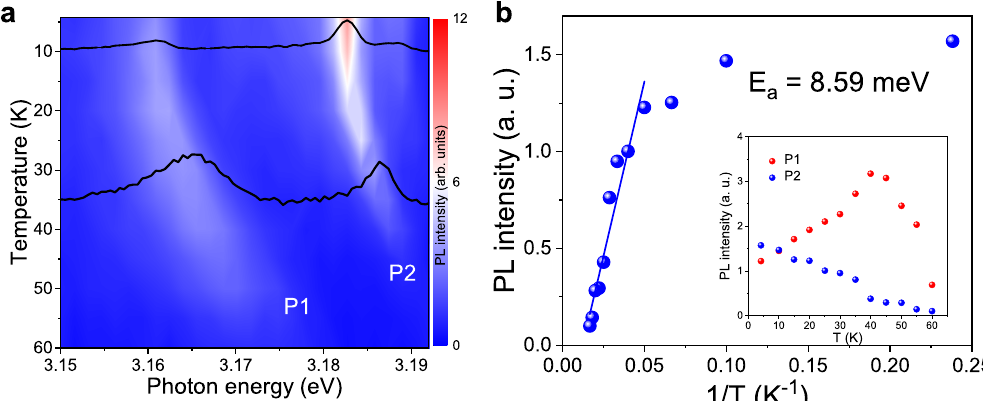
Fig. 1 Temperature-dependent micro-photoluminescence. a Temperature-dependent PL spectral mapping from graphene. Upper and bottom insets depict the PL spectra taken at 4.2 and 35 K, respectively. b The Arrhenius plot of the P2 emission. Inset depicts the integrated PL intensity of the P1 and P2 emission peaks as a function of temperature. All intensities are deduced by Gaussian fi tting as shown in Supplementary Fig. 1.